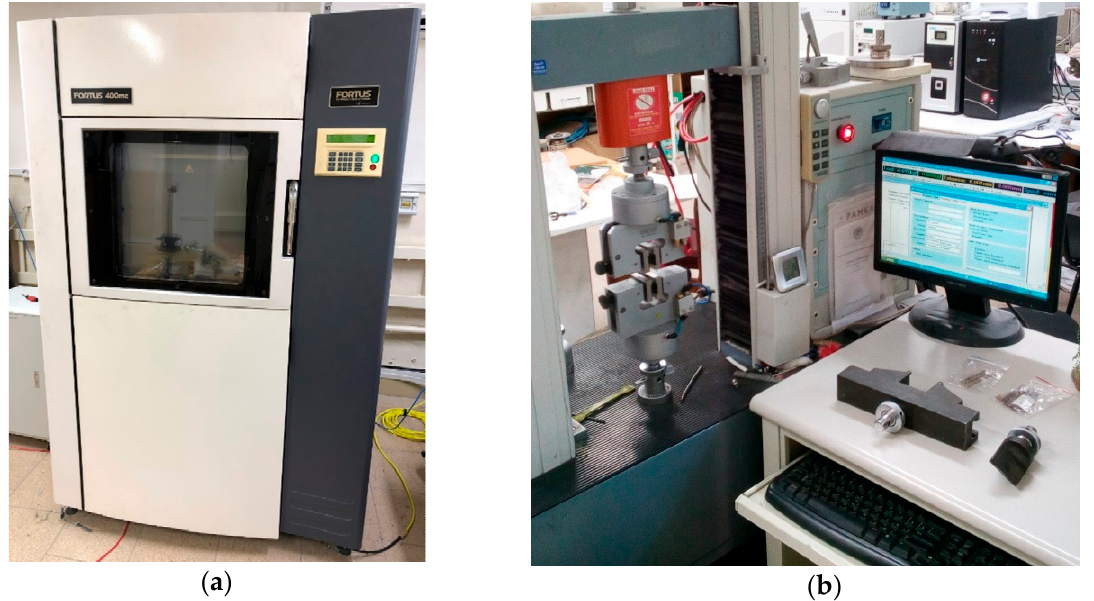
Figure 1. 3D printer Fortus 400mc ( a ) and universal testing machine GT-TCS 2000 ( b ).